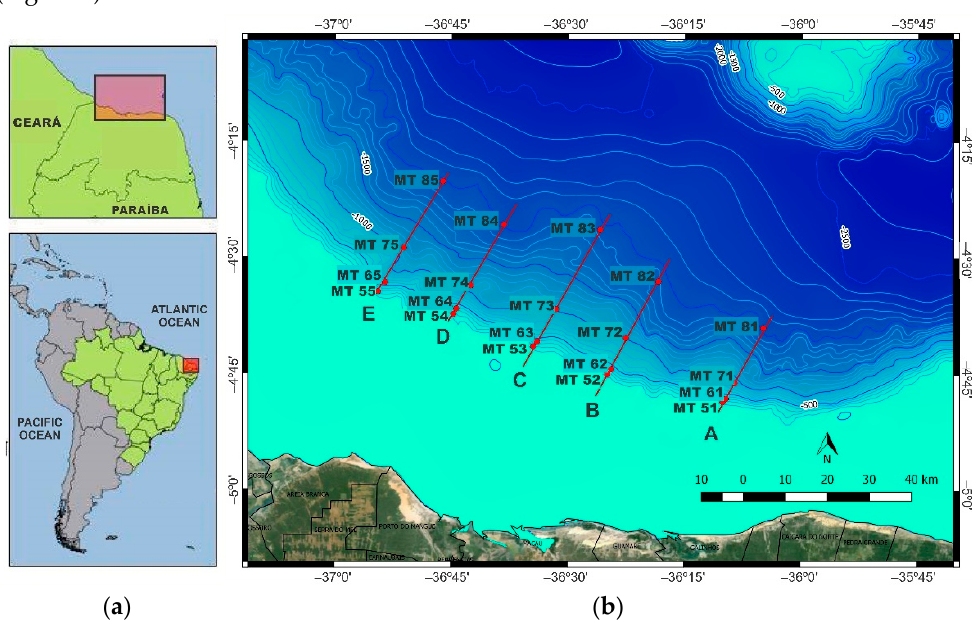
Figure 1. Study area. ( a ) South America—Brazil in green; rectangle delimiting the northern coast of Rio Grande do Norte. ( b ) Location of sampling stations at the continental slope ( • ); transects signed with the red